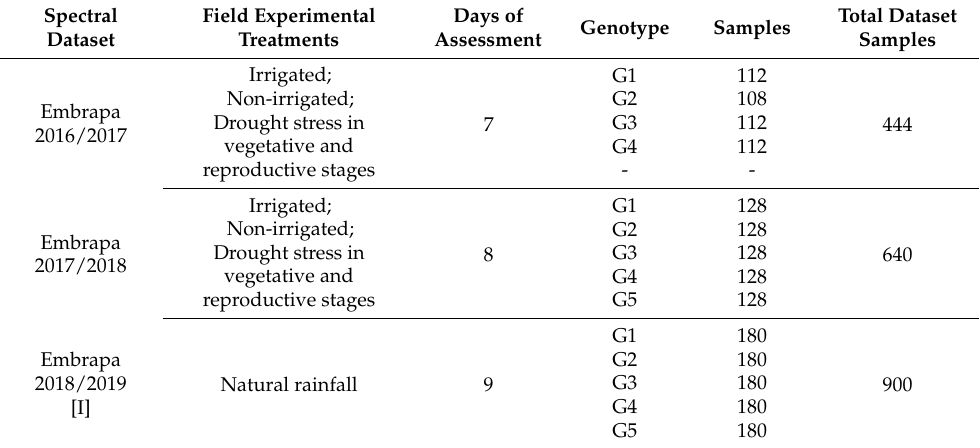
Table 1. Description of the spectral datasets composed by field trial assessments: experimental treatments, genotypes, and the numbers of samples.